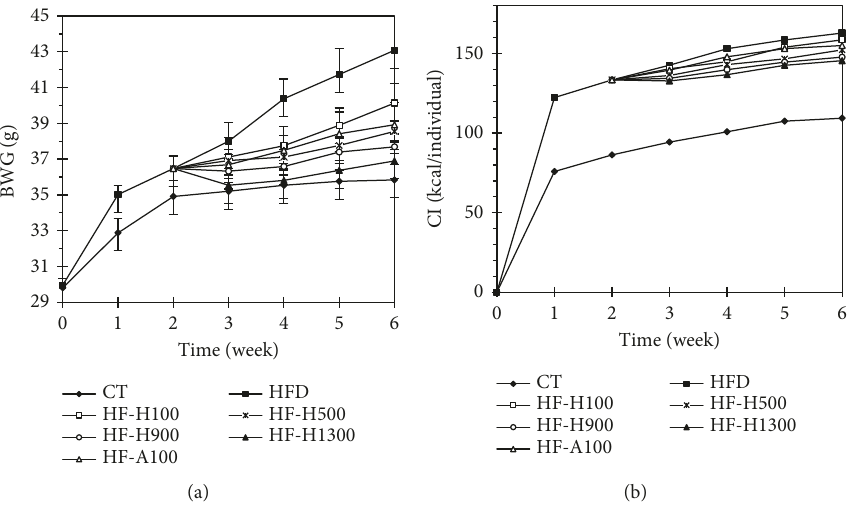
Figure 2: (a) Body weight gain (BWG, mean ± standard deviation, n � 5) and (b) caloric intake (CI, mean, n � 5) of tested